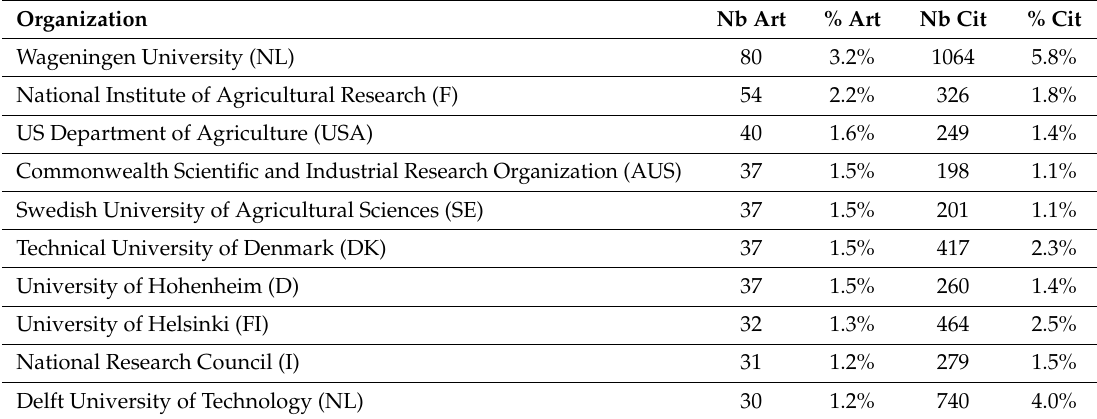
Table 6. The ten most important organizations, with articles and citations ( n = 2489).